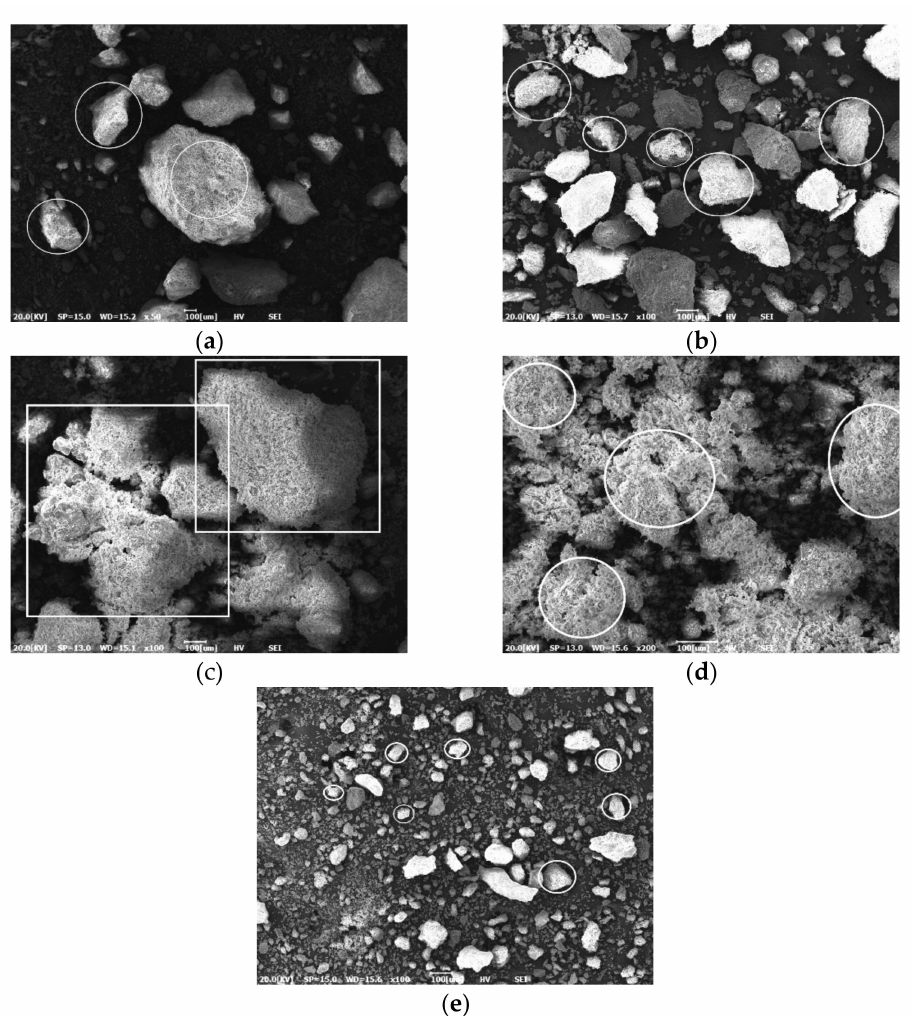
Figure 5. Micrograph of the Fe-rich mine waste samples from: ( a ) waste dump, ( b ) tailings, ( c ) pond 1, ( d ) pond 2, and ( e ) pond 3. The round and square shapes depict the porous magnetite minerals present in the raw Fe-rich mine